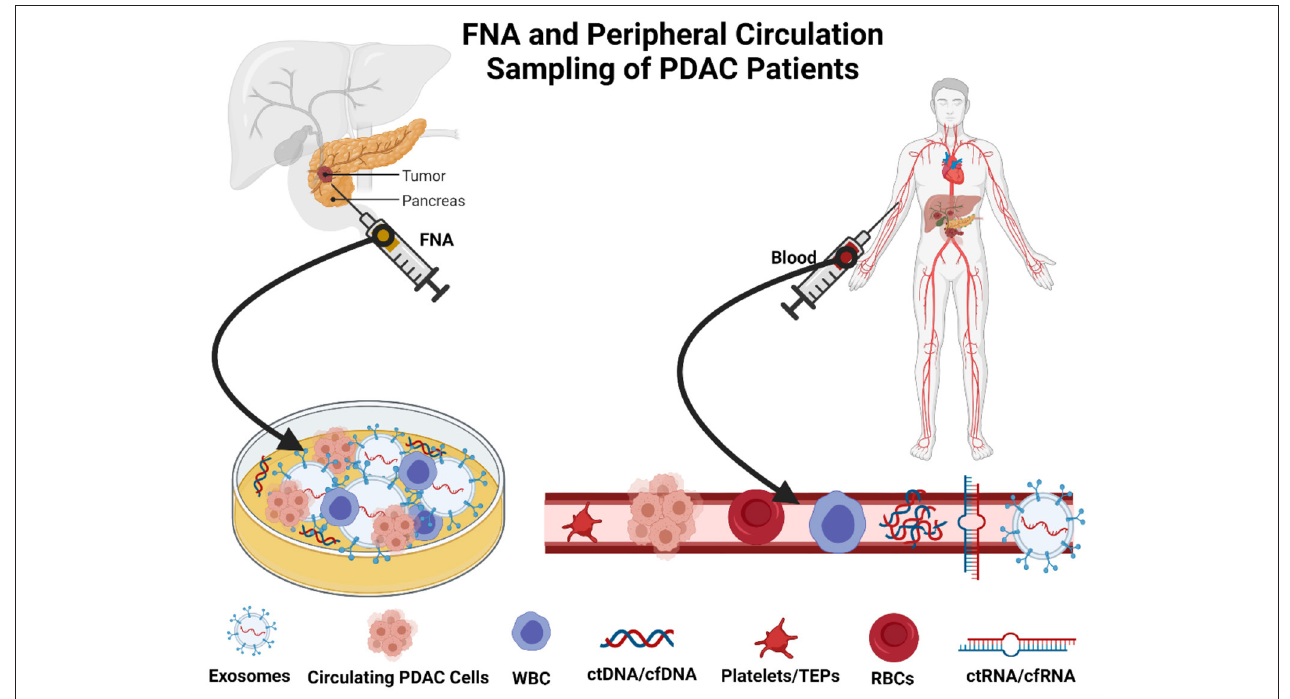
FIGURE 2 | Method of sampling in patients with pancreatic ductal adenocarcinoma (PDAC). Created with